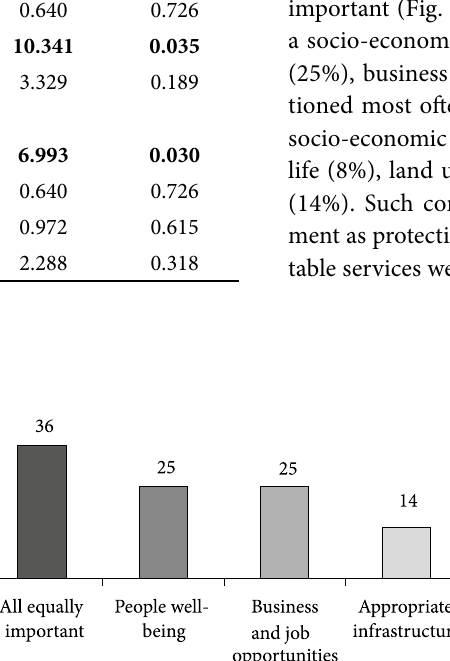
Fig. 1. The most important components of a socio-economic environment. Survey results